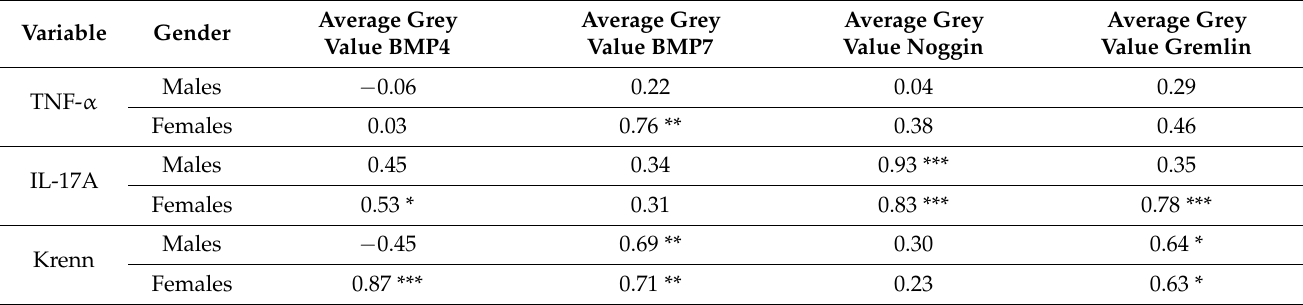
Figure 8. Pristane-induced arthritis upregulates BMP-7 and Gremlin expression in synovial tissue in female rats more than in male rats. ( A ) Representative immunohistochemical pictures show staining with anti-BMP-7 and anti-Gremlin antibodies in paraffin-embedded sections of metatarsophalangeal joints obtained from male and female DA rats: control (treated with saline); PIA onset (between 9th and 12th day after induction); PIA peak (between 16th and 20th day after induction); PIA remission (between 20th and 25th day after induction). BMP-7 is expressed in stromal cells and synovial lining cells. *gender differences in immunohistochemical staining of stroma; arrows: gender differences in immunohistochemical staining of synovial lining cell layer. ( B , C ) BMP-7 and Gremlin immunoreactivity in synovial tissue of metatarsophalangeal joints. Immunohistochemical staining quantification was performed using Cell F v3.1 software analysis on 12 regions of interest (3 slides/rat × 6 rats/group). Values are expressed as mean grey value ± SD ( N = 24). One-way ANOVA followed by the post hoc Scheff é test: * p < 0.05, ** p < 0.01 and *** p < 0.001. Scale bars indicate 50 µ m. Table 2. Pearson’s correlation between synovial expressions of BMPs, Noggin, and Gremlin, IL-17A and TNF- α levels in serum, and Krenn synovitis